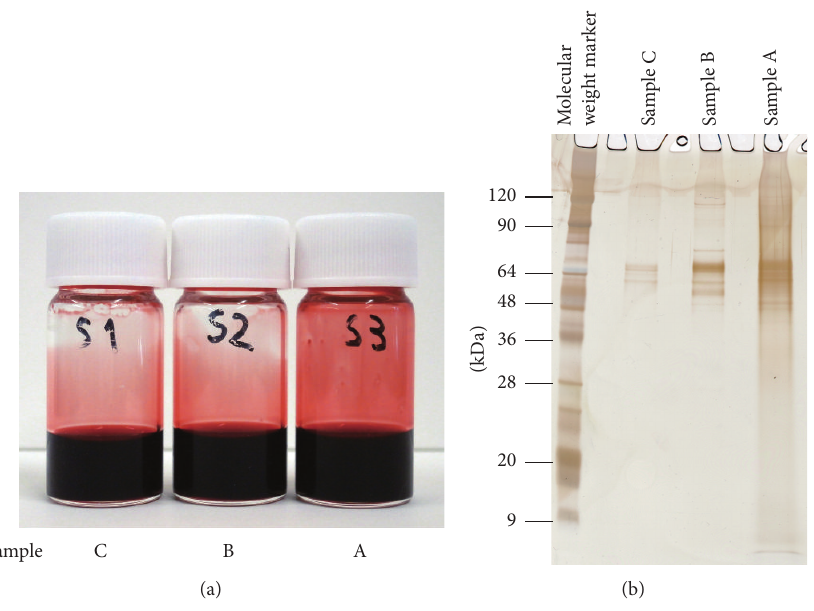
Figure 4: (a) Images of carmine suspensions in SDS-PAGE running buffer. Left: Sample C (carminic acid purified using divinylbenzene resin, Kishi Kasei). Middle: Sample B (carminic acid, Kishi Kasei). Right: Sample A (cochineal extract, Biocon). (b) SDS-PAGE results for protein contaminants in carmine with the Nanosep 3K Omega.